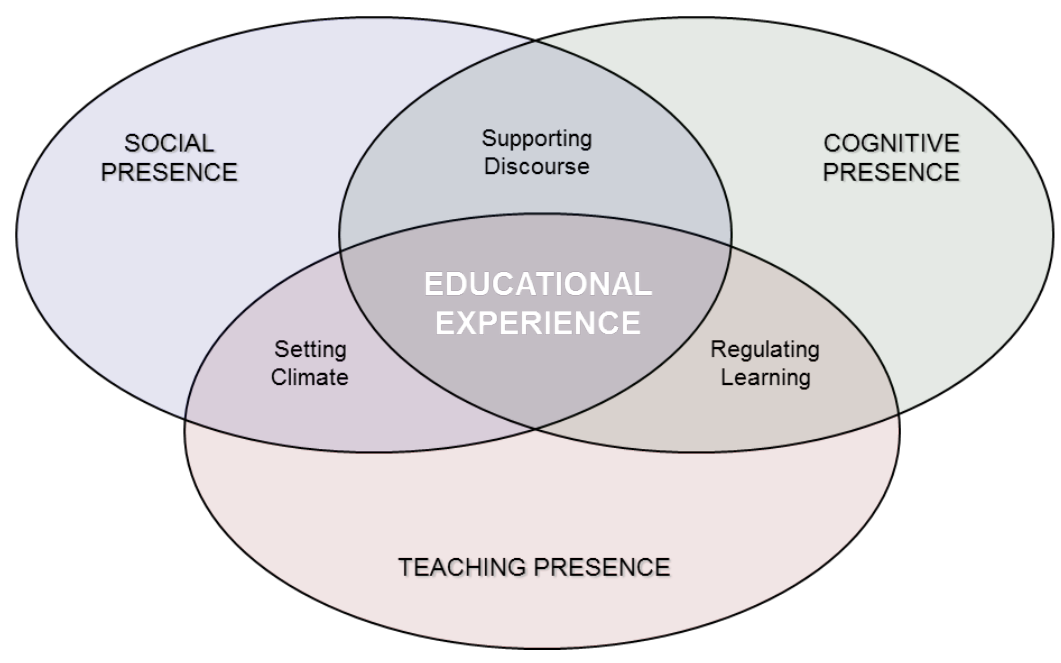
Figure 1. Community of Inquiry Framework (2011) describing each Presence in turn. Adapted from Garrison, D. R., (2011). E-learning in the 21 st Century (2 nd ed.). New York: Routledge. Cognitive Presence